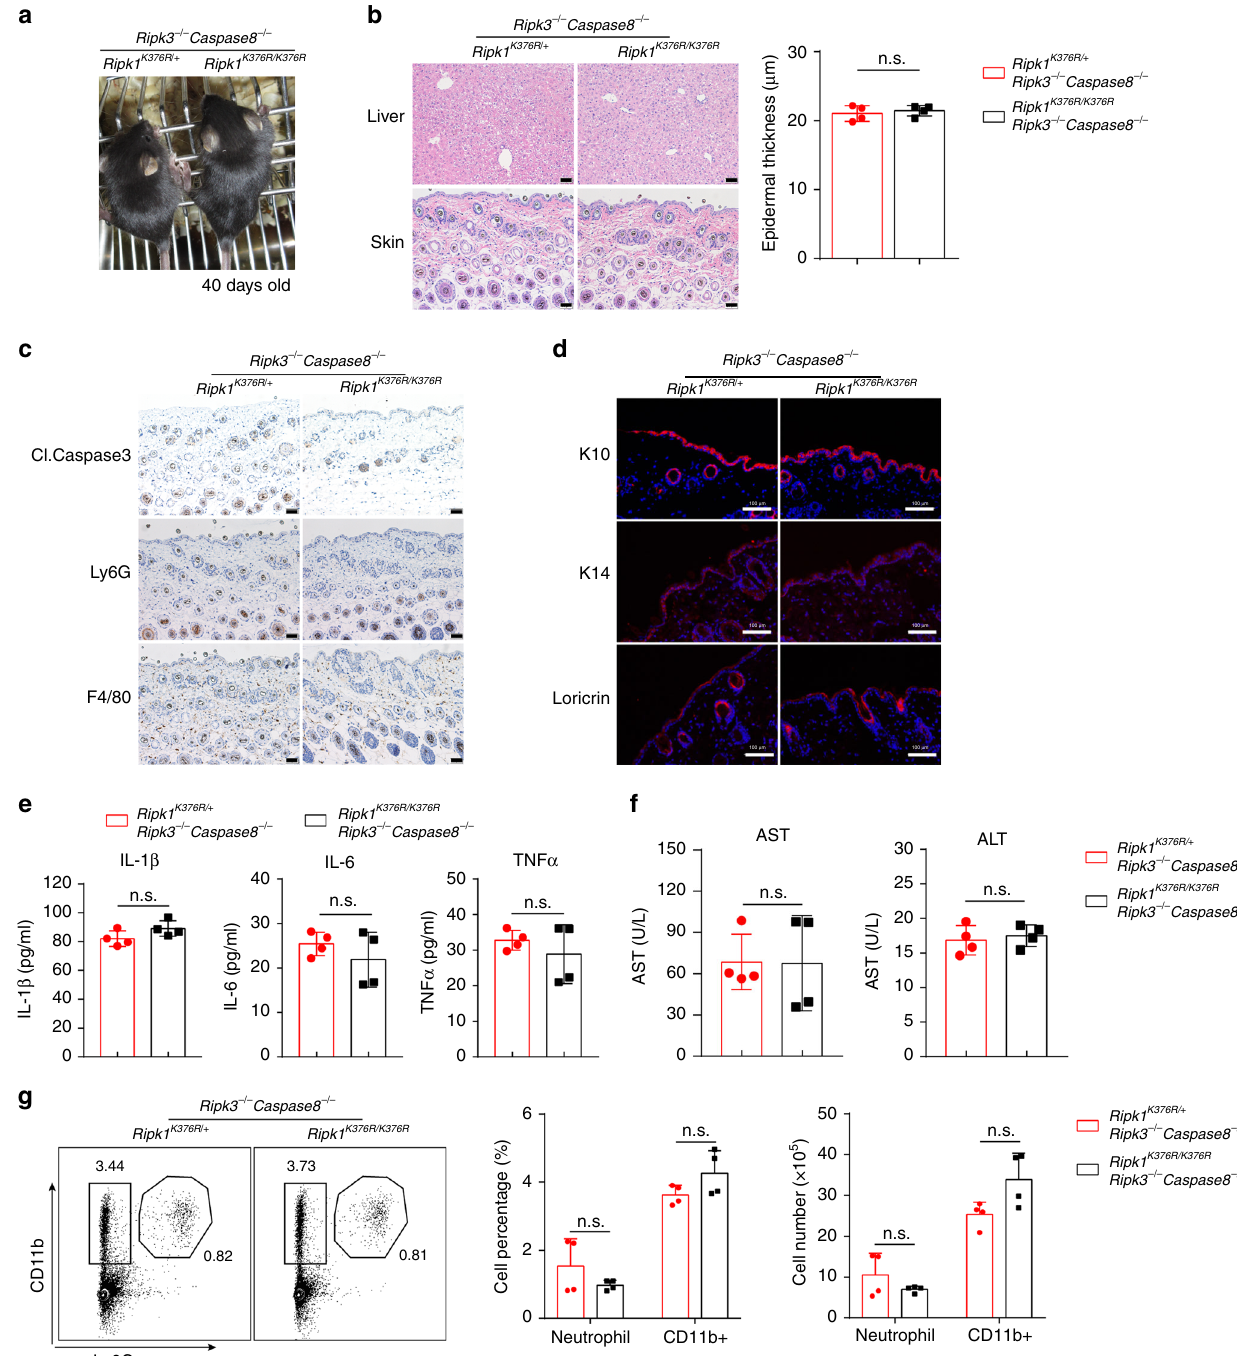
Fig. 5 Co-deletion of RIPK3 and Caspase8 fully rescue Ripk1 K376R/K376R mice. a Representative macroscopic images of Ripk1 K376R/K376R Ripk3 − / − Caspase8 − / − and Ripk1 K376R/ + Ripk3 − / − Caspase8 − / − littermate mice at P40. b H&E staining of liver and skin sections of Ripk1 K376R/K376R Ripk3 − / − Caspase8 − / − and Ripk1 K376R/ + Ripk3 − / − Caspase8 − / − littermate mice at P40 (scale bar, 50 μ m), and microscopic quanti fi cation of the epidermal thickness from H&E results ( Ripk1 K376R/ + Ripk3 − / − Caspase8 − / − mice: n = 4; Ripk1 K376R/K376R Ripk3 − / − Caspase8 − / − mice: n = 4). c , d Immunohistochemical staining of F4/80, Ly6G, and cleaved Caspase3 (scale bar, 50 μ m) ( c ) or immuno fl uorescence staining of Loricrin, K10, and K14 (scale bar,100 μ m) ( d ) in skin sections of Ripk1 K376R/K376R Ripk3 − / − Caspase8 − / − and Ripk1 K376R/ + Ripk3 − / − Caspase8 − / − littermate mice at P40. e Cytokines in liver homogenates were determined with the indicated genotypes at P40 ( Ripk1 K376R/ + Ripk3 − / − Caspase8 − / − mice: n = 4; Ripk1 K376R/K376R Ripk3 − / − Caspase8 − / − mice: n = 4). f AST and ALT in blood were determined with the indicated genotypes at P40 ( Ripk1 K376R/ + Ripk3 − / − Caspase8 − / − mice: n = 4; Ripk1 K376R/K376R Ripk3 − / − Caspase8 − / − mice: n = 4). g Flow cytometry and statistical results of splenocytes stained with Ly6G and CD11b from Ripk1 K376R/K376R Ripk3 − / − Caspase8 − / − and Ripk1 K376R/ + Ripk3 − / − Caspase8 − / − littermate mice at P40 ( Ripk1 K376R/ + Ripk3 − / − Caspase8 − / − mice: n = 4; Ripk1 K376R/K376R Ripk3 − / − Caspase8 − / − mice: n = 4). CD11b + Ly6G + cells were identi fi ed as neutrophils. In b , e – g , data are mean± s.e.m. Statistical signi fi cance was determined using a two-tailed unpaired t